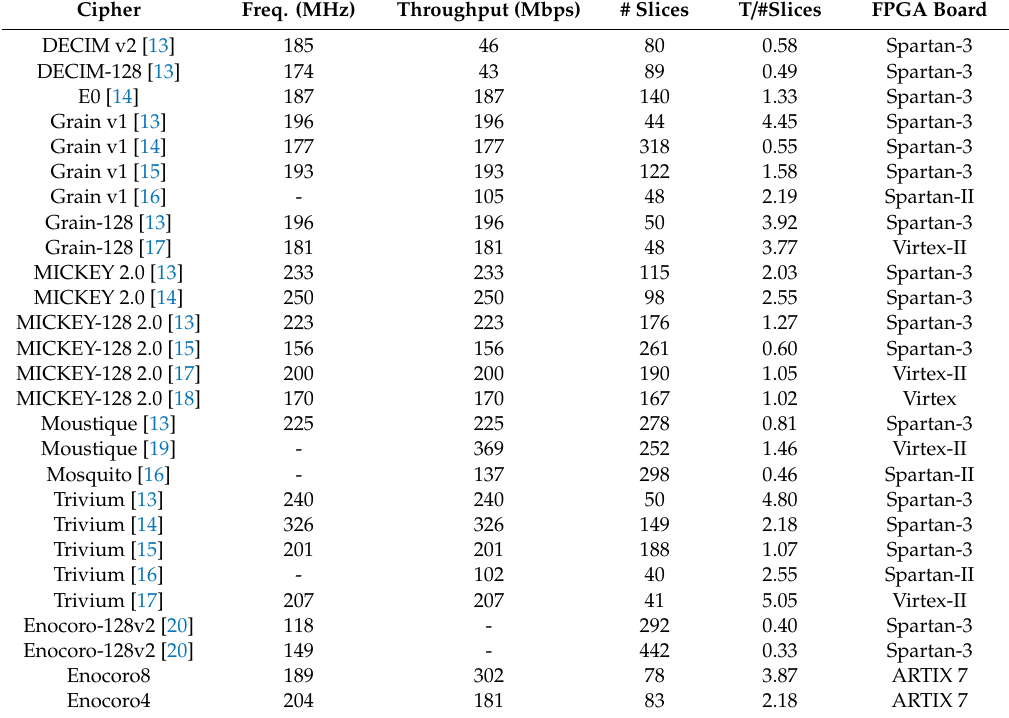
Table 3. Comparisons of the proposed Enocoro-128v2 architectures with implementations of other cryptographic